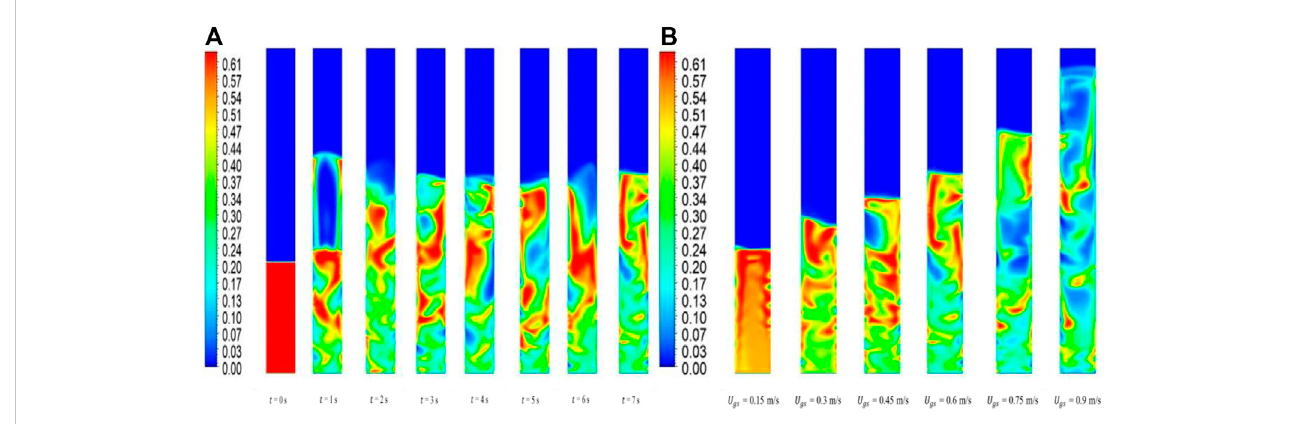
Time-averaged solid-phase volume fraction contour for 25% mixture and 0.48 m. (A) Transient fl ow patterns and (B) steady state fl ow patterns at different super fi cial gas